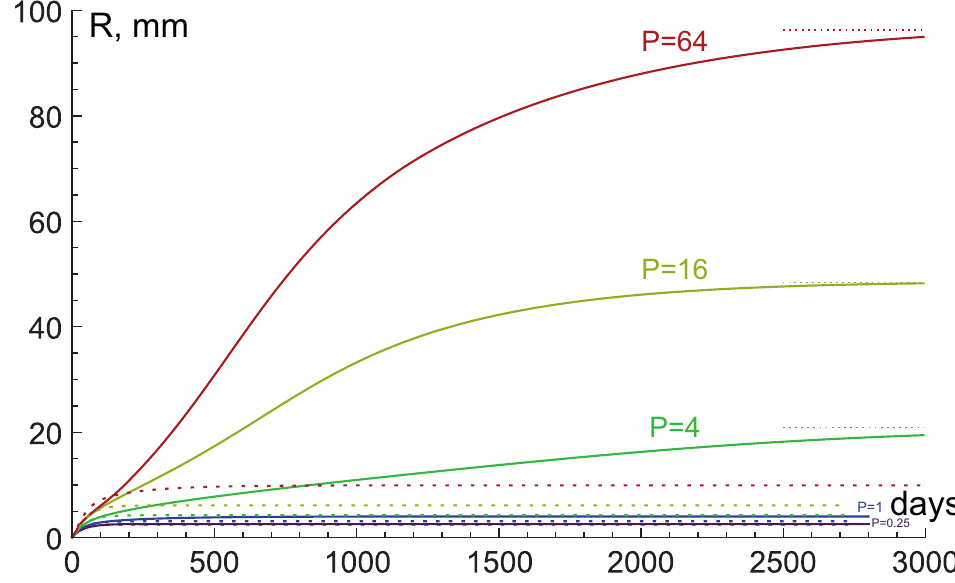
Figure 9. Tumor growth curves, produced by numerical simulations of the system of Equation (6) under different nutrient supply levels P and tissue hydraulic conductivity K / µ = 0.03 (solid lines) and K / µ = 0.3 (dashed lines). Dotted lines denote the limit values of tumor radii under K / µ =